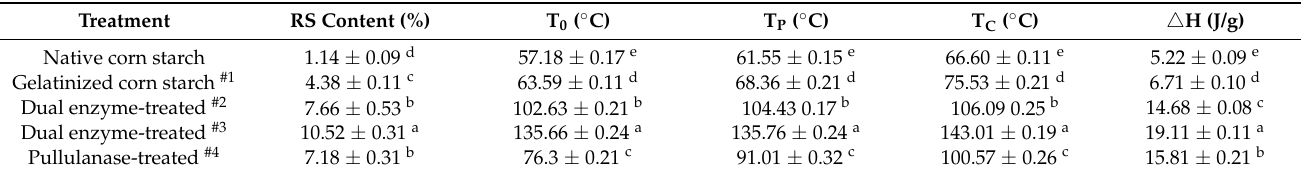
Table 4. Thermal transition properties of native and enzyme-treated